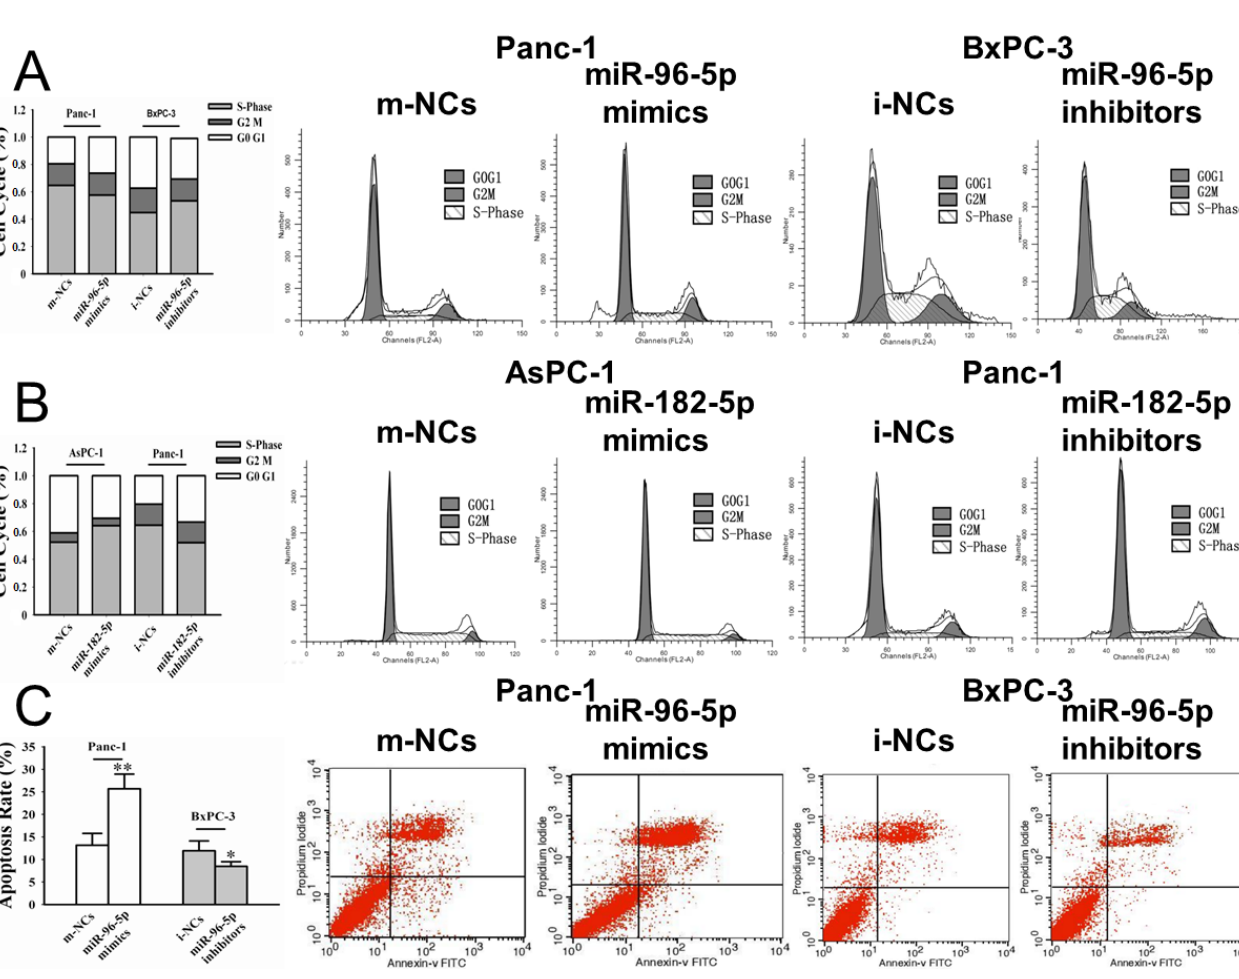
Figure 3. Effects of miR-96-5p and -182-5p on cell cycle and apoptosis in PC cells. ( A ) Flow cytometric analysis of indicated PC cancer cells transfected with miR-96-5p mimics, inhibitors or their respective negative controls (NCs) in Panc-1 and BxPC-3. MiR-96-5p induced cell cycle arrest at G1/G0 phase; ( B ) Flow cytometric analysis of indicated PC cancer cells transfected with miR-182-5p mimics, inhibitors or their respective NCs in AsPC-1 and Panc-1. MiR-182-5p induced cell cycle arrest at S phase; ( C ) PC cancer cells transfected with miR-96-5p mimics, inhibitors or their respective NCs in Panc-1 and BxPC-3, and the apoptosis was measured by flow cytometry. * p < 0.05; ** p <